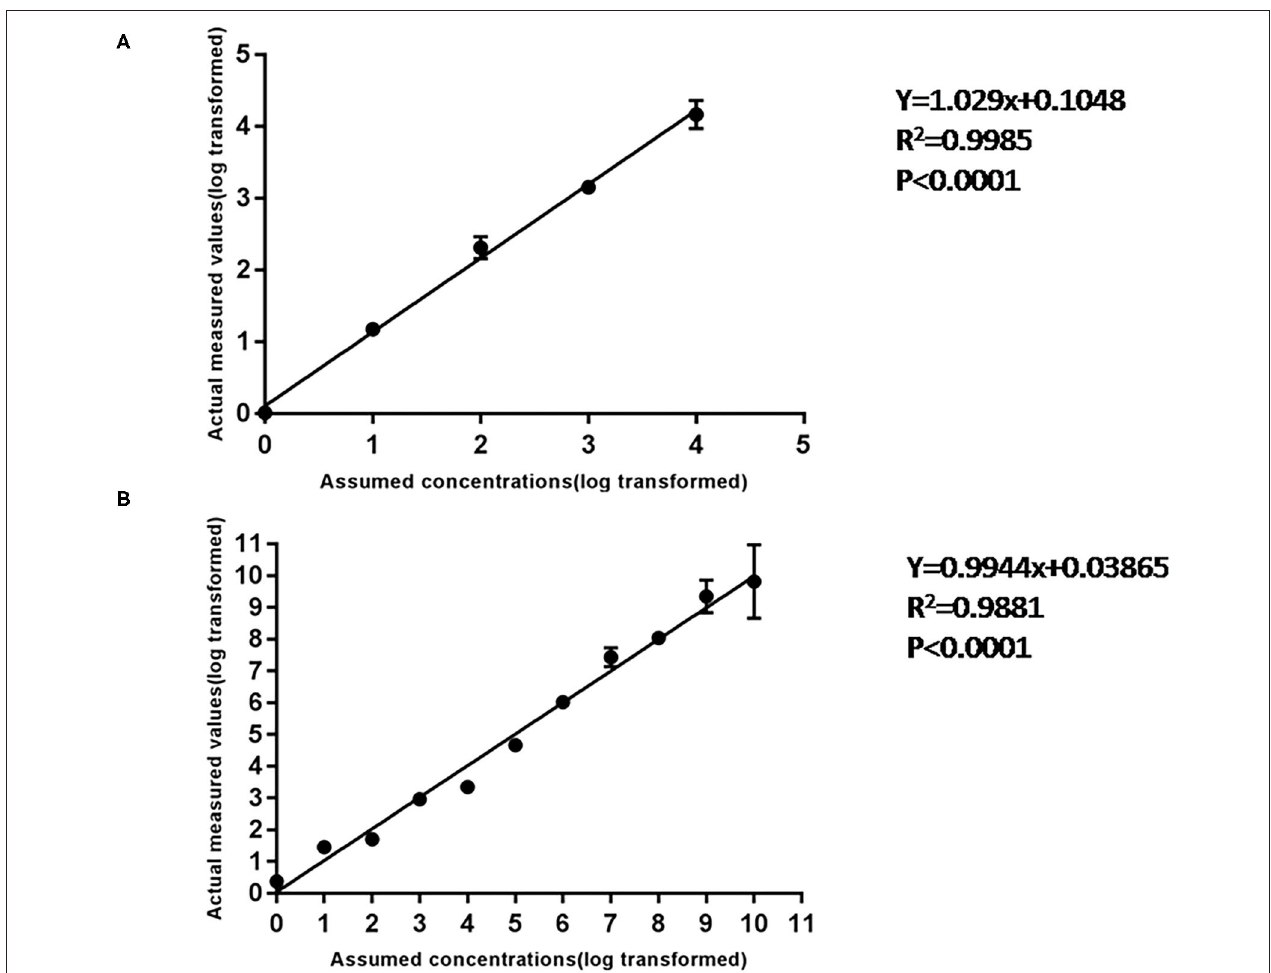
FIGURE 4 | The standard curve of cdPCR and qPCR. (A) The standard curve of cdPCR. The slope of this linear fitting equation is 1.029 and the Y-intercept is 0.1048. (B) The standard curve of qPCR. The slope of this linear fitting equation is 0.9944 and the Y-intercept is